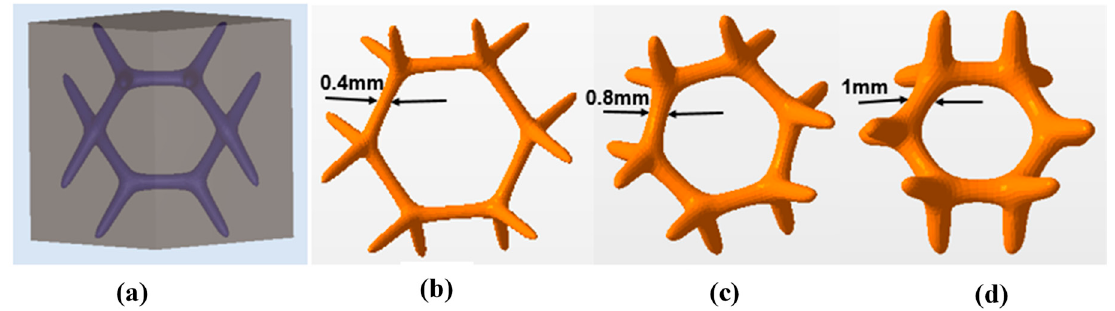
Figure 2. Unit cell with di ff erent struts. ( a ) Unit size in block ( b ) with 0.4 mm beam thickness, ( c ) 0.8 mm beam thickness, ( d ) 1 mm beam thickness.